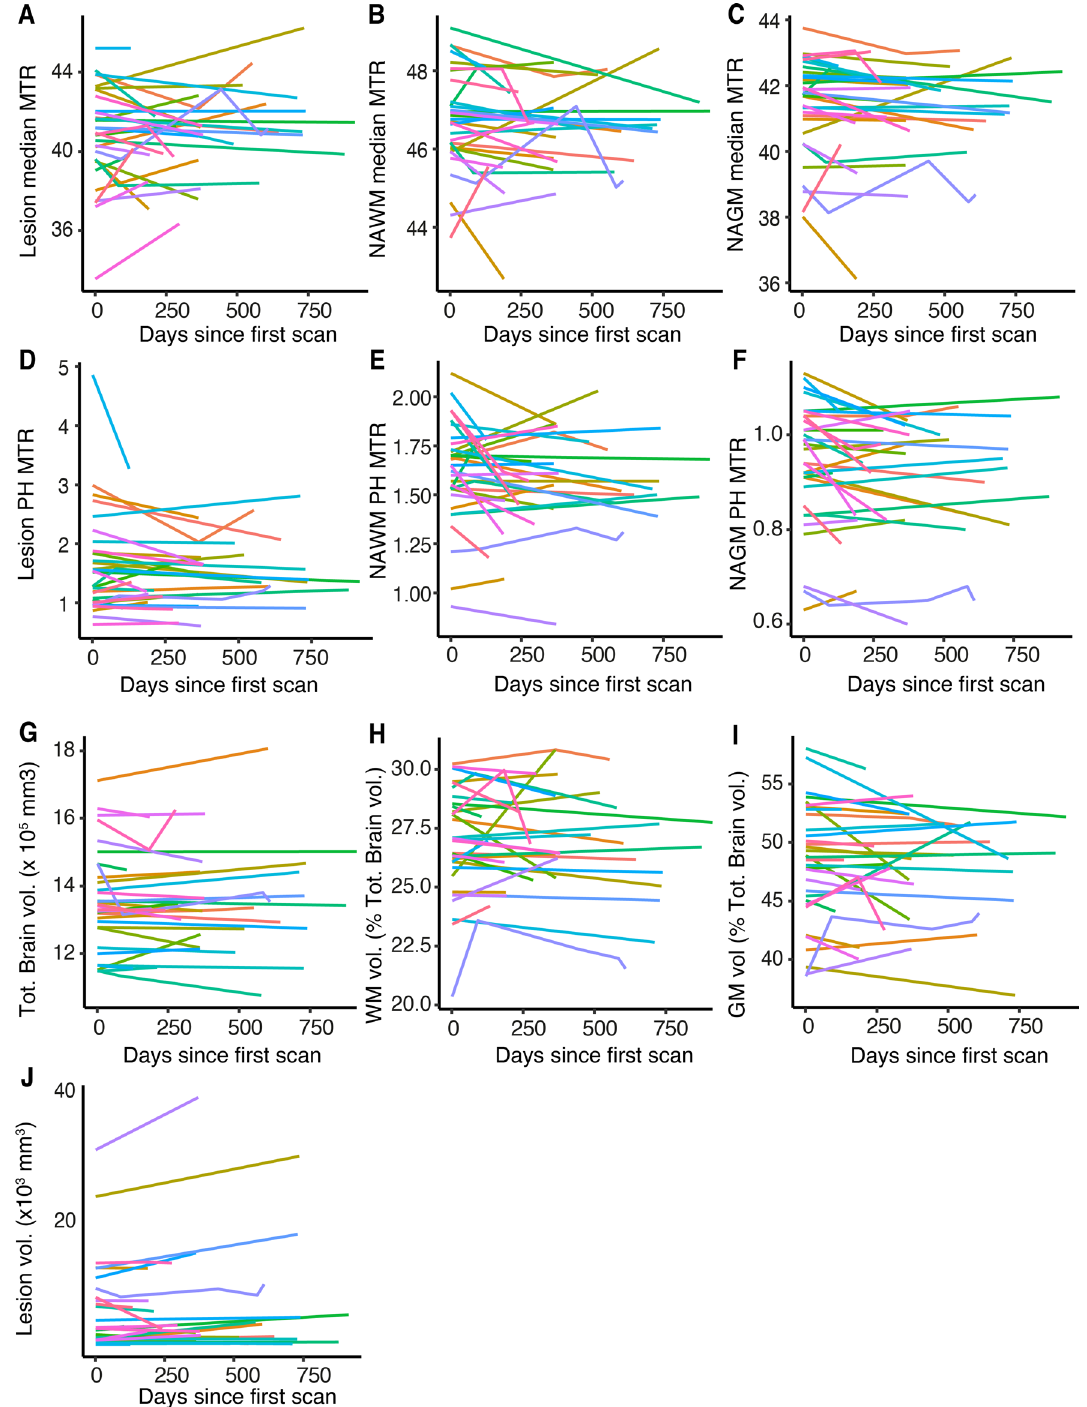
Figure 2. Longitudinal variation in MRI. Longitudinal evolution of ( A – C ) median and ( D – F ) peak height MTR in each tissue class (lesions, NAWM, NAGM) as well as ( G ) total brain volume, ( H ) white matter, ( J ) grey matter and ( I ) lesion volume. The same color represents each individual patient (N = 33) throughout the graphs. All patients were scanned using the same scanner protocol. MTR magnetization transfer ratio, NAWM normal appearing white matter, NAGM normal appearing grey matter, PH peak height, Tot. total, vol. volume, WM white matter, GM grey matter (Image generated with Rv3.6.1, https ://www.R-proje